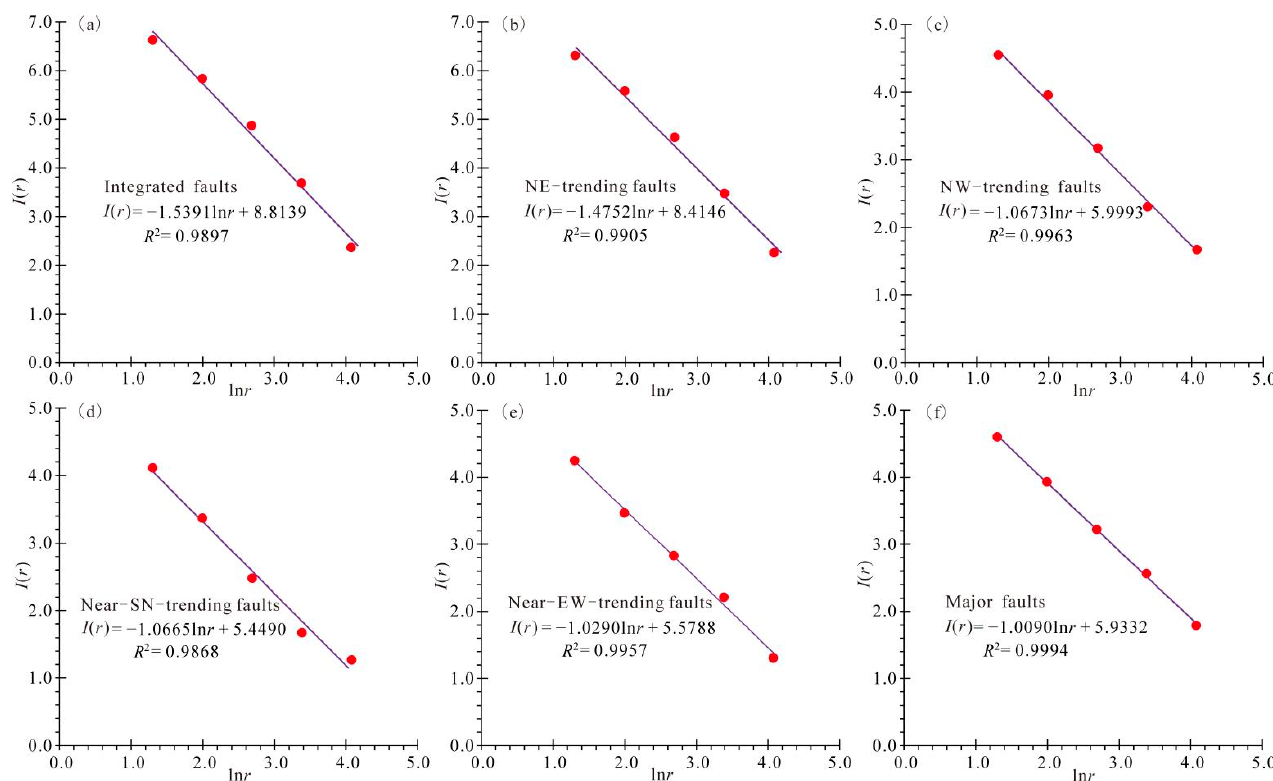
Figure 4. Linear fitting diagrams of the information dimension (IND) calculation for faults in the eastern Guizhou Pb–Zn metallogenic belt (EGMB). The ln r versus I ( r ) plots of IND data for ( a ) Inte ‐ grated faults; ( b ) NE ‐ trending faults; ( c ) NW ‐ trending faults; ( d ) Near ‐ SN ‐ trending faults; ( e ) Near ‐ EW ‐ trending faults; and ( f ) Major faults, showing their linear regression parameters.